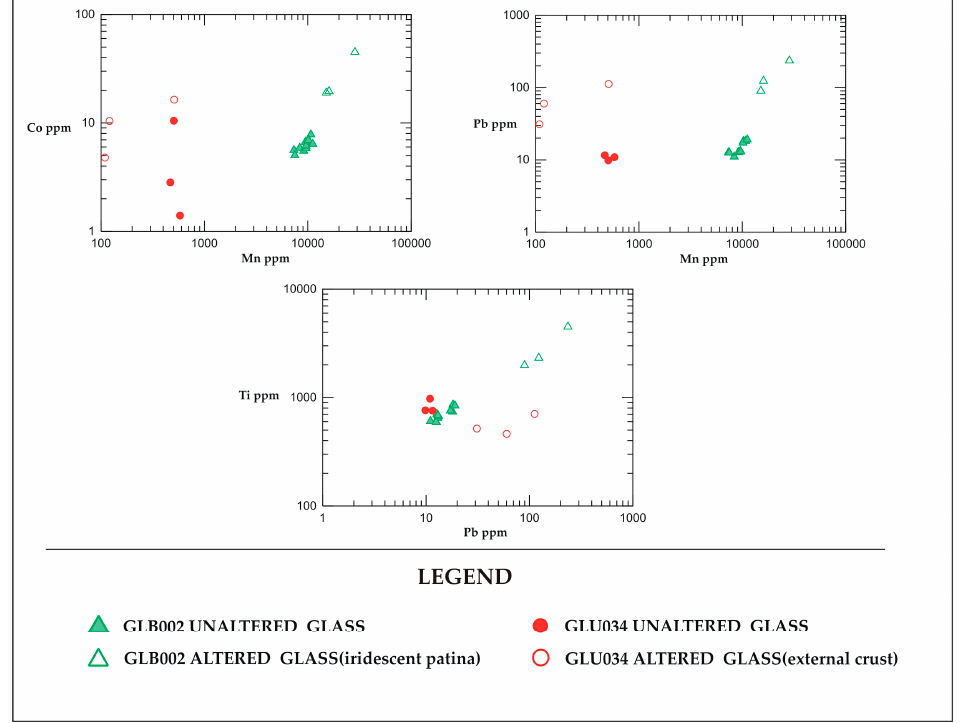
Figure 13. Binary diagrams relative to the concentrations of some trace elements such as: Co vs Mn, Pb vs Mn and Ti vs Pb, detected on different morphological glass areas.